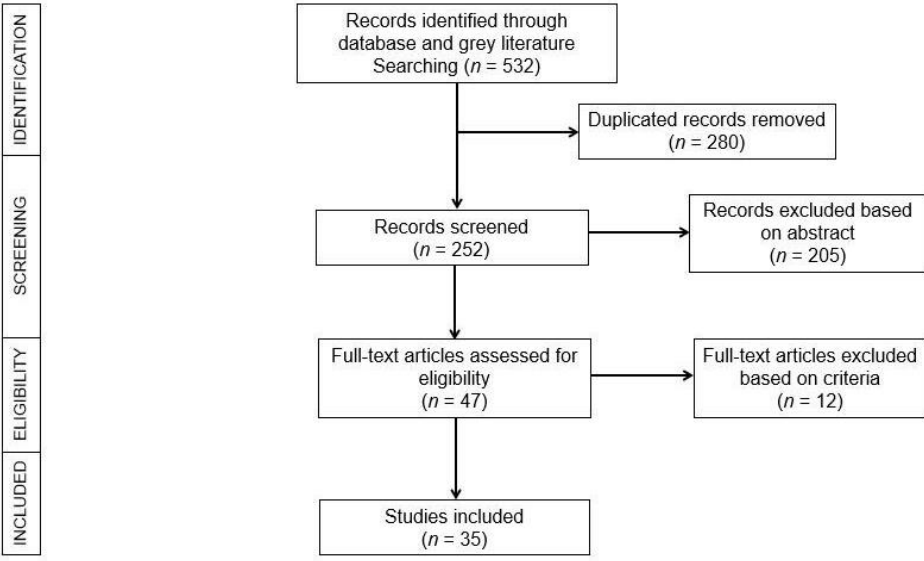
Figure 2. The PRISMA flowchart illustrating the literature selection